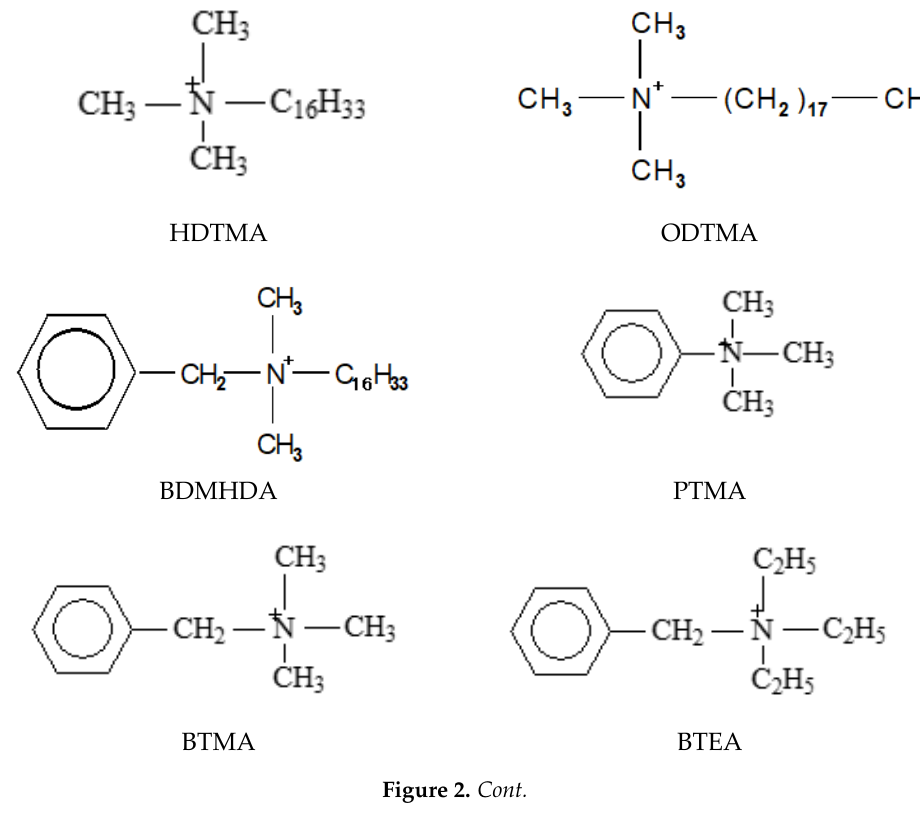
Table 1. FTIR vibration bands (cm − 1 ) of Alachlor and Alachlor sorbed on Montmorillonite and its for alachlor sorbed on montmorillonite-BTMA 0.5 mmol/g (Table 1). This shift indicates complexes